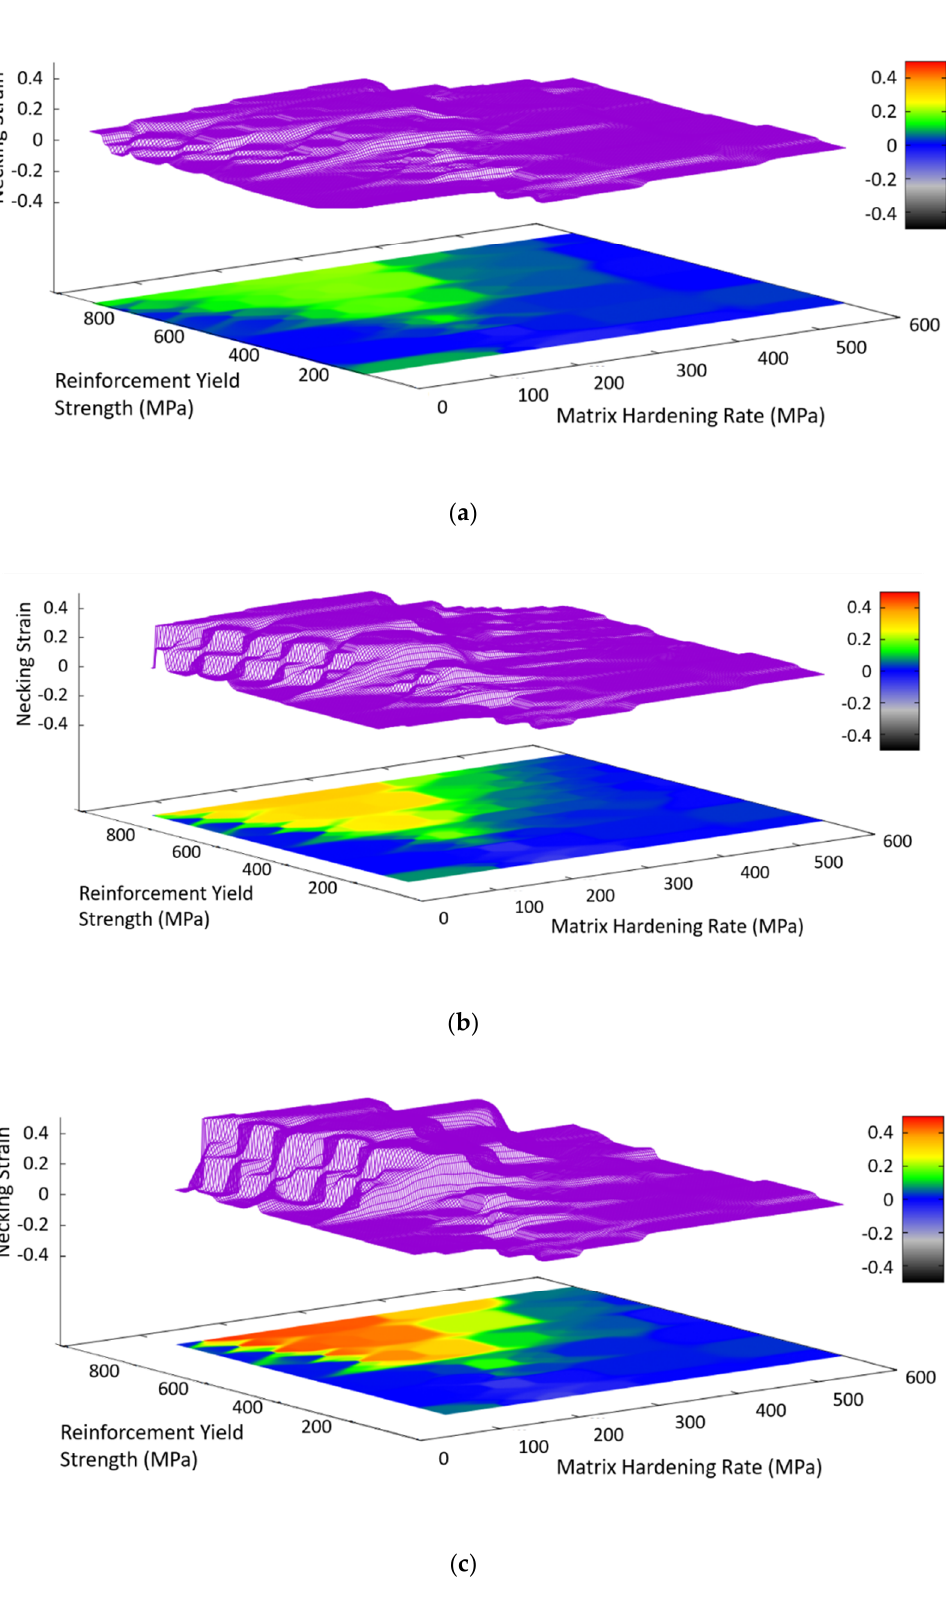
Figure 7. Plots of the di ff erence in necking strain between corrugation reinforced composites and their straight reinforced composite counterparts over a range of values of reinforcement yield strength and matrix hardening rate. Each plot corresponds to a di ff erent corrugation height, h; ( a ) 2 mm, ( b ) 3 mm, and ( c ) 4 mm. For all of the simulations represented by these plots, the matrix yield strength was kept constant at 300 MPa, the reinforcement hardening rate was fixed at 500 MPa, and the corrugation geometry had a fixed period of 8 mm and a volume fraction of